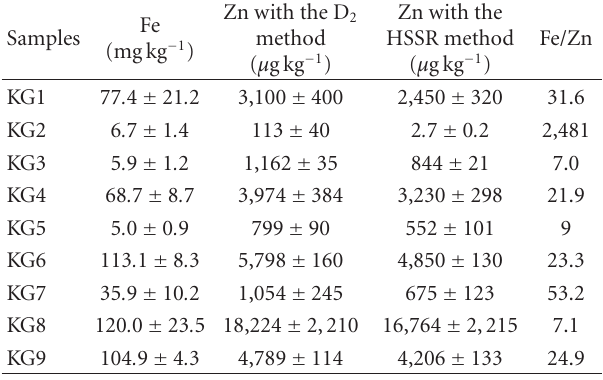
Table 4: Water-extractable Fe and Zn concentrations (mean value ± standard deviation, n = 3) in kitchen garden (KG) soil samples.